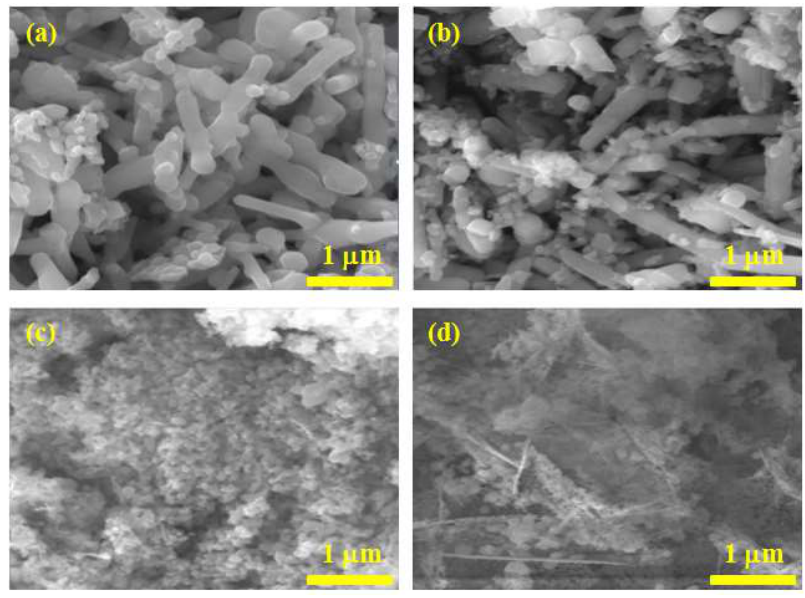
Figure 2. SEM image of ( a ) ZnO, ( b ) ZnO with the element Co doping, ( c ) ZnO with the element Gd doping, and ( d ) ZnO with Co/Gd doping.